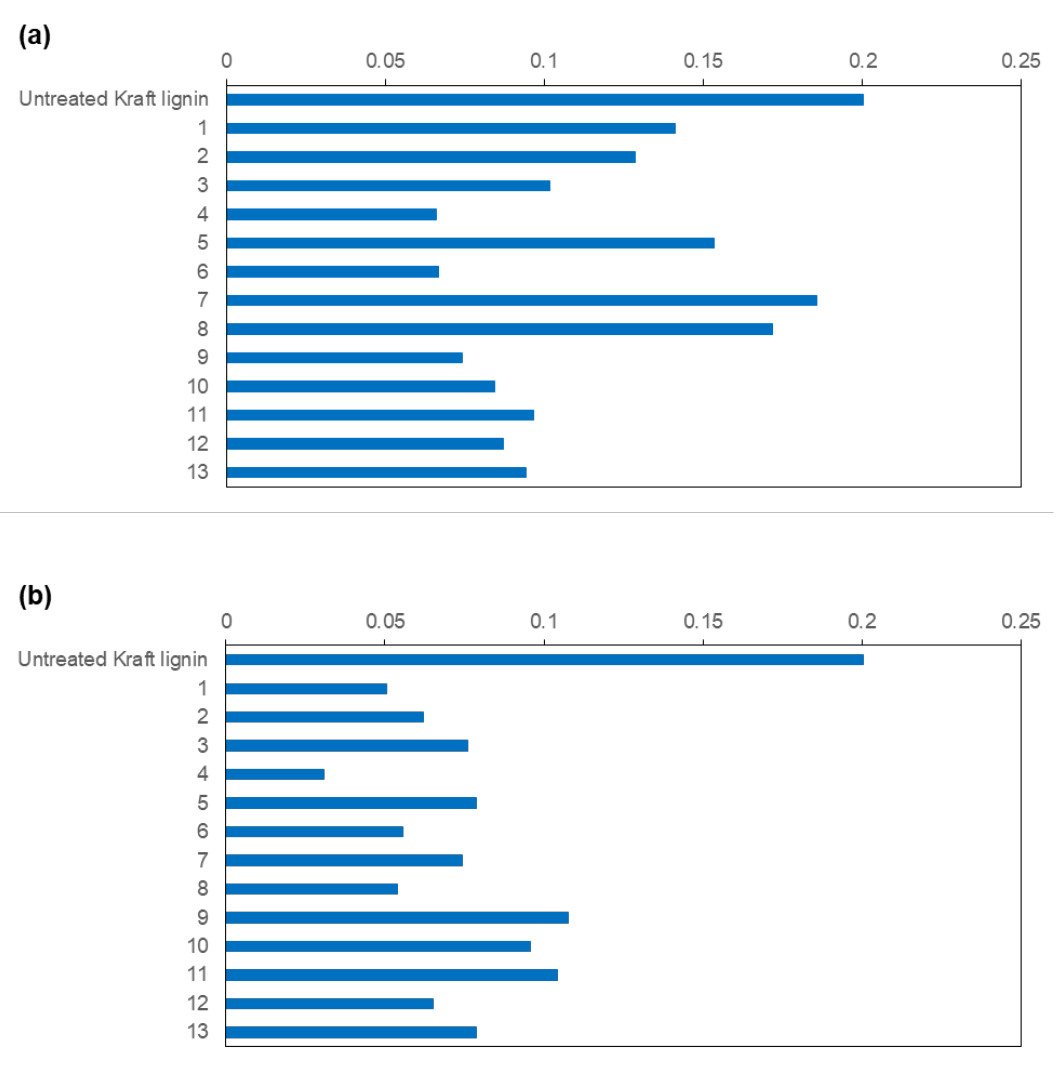
Figure 5. Antioxidant activity of the resulting treated lignins with MtL ( a ) and SiLA ( b ) laccases expressed as TEAC (experiments resulting from CCD).